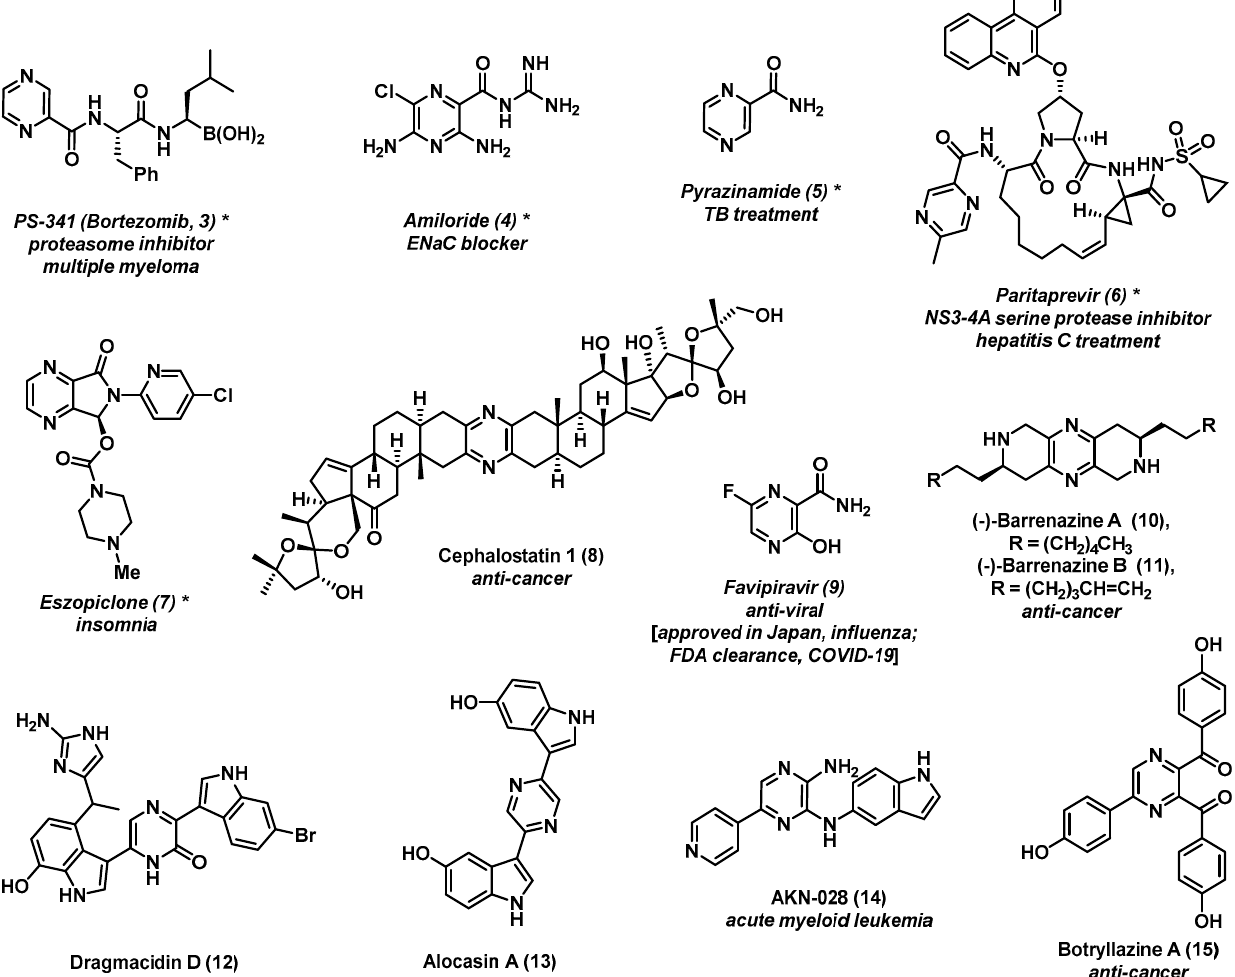
Figure 2. Pyrazine heterocycles that possess a diversity of biological activities, including multiple therapeutic agents used in human medicine.